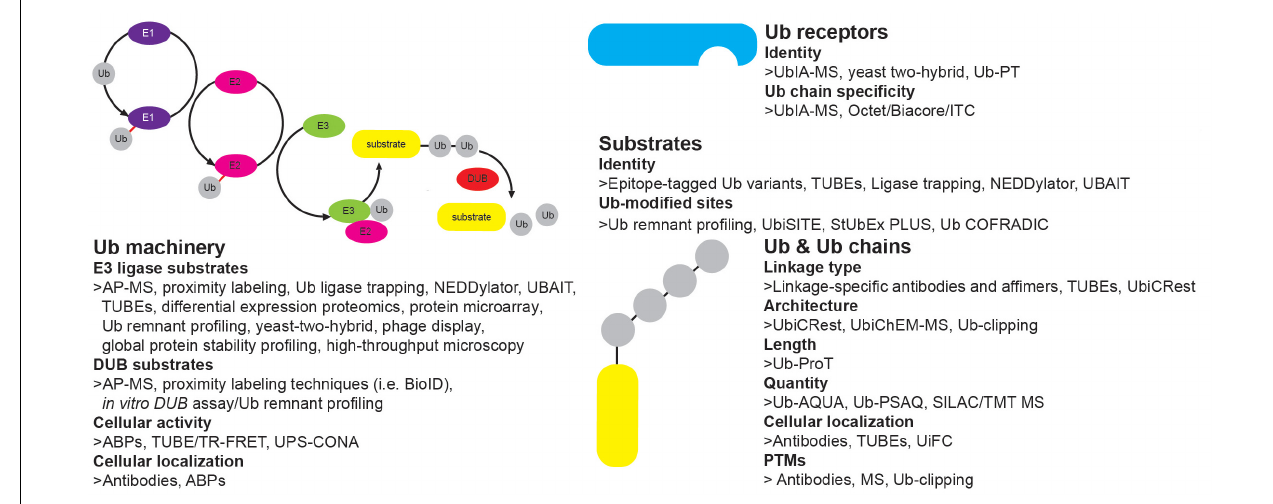
FIGURE 4 | Tools to study ubiquitin system. Overview of different approaches to study features of Ub signaling: E3 ligase and DUB enzymes (enzyme abundance, activity, cellular localization), Ub chains (type, architecture, length, quantity, cellular localization, PTMs), ubiquitinated substrates (identity, modification site, type of modification) and Ub receptors (identity, Ub linkage